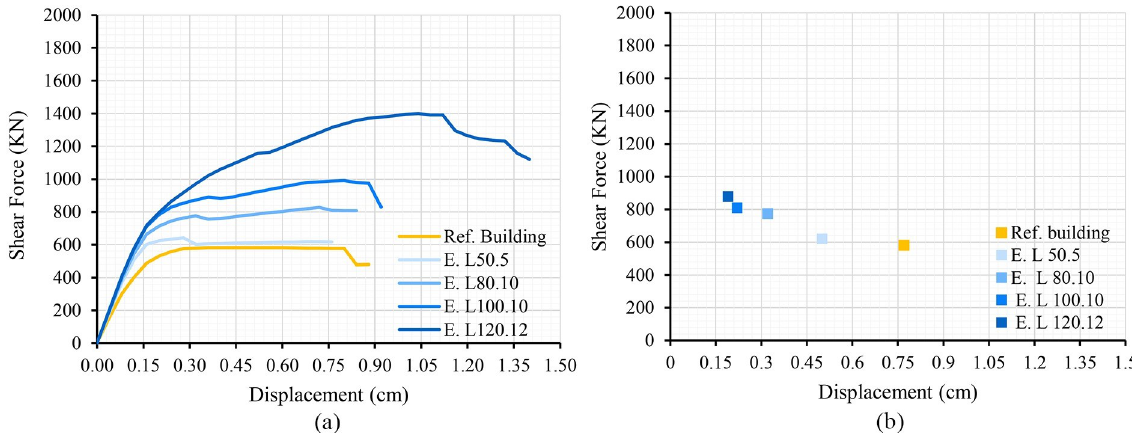
Fig 9. Capacity curves (a) and performance points (b) of the models adding steel profiles in the openings varying the profile